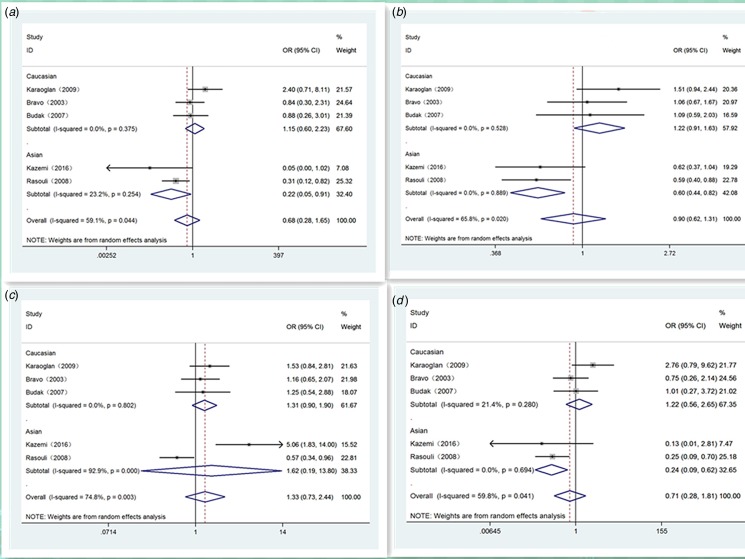
Forest plot of IL-10-1082 loci polymorphism on Brucellosis risk in different genetic models. A: recessive model (AA vs. GG/GA); B: dominant model (AA/GA vs. GG); C: homozygote model (AA vs. GG) and D: allele model (A vs. G).